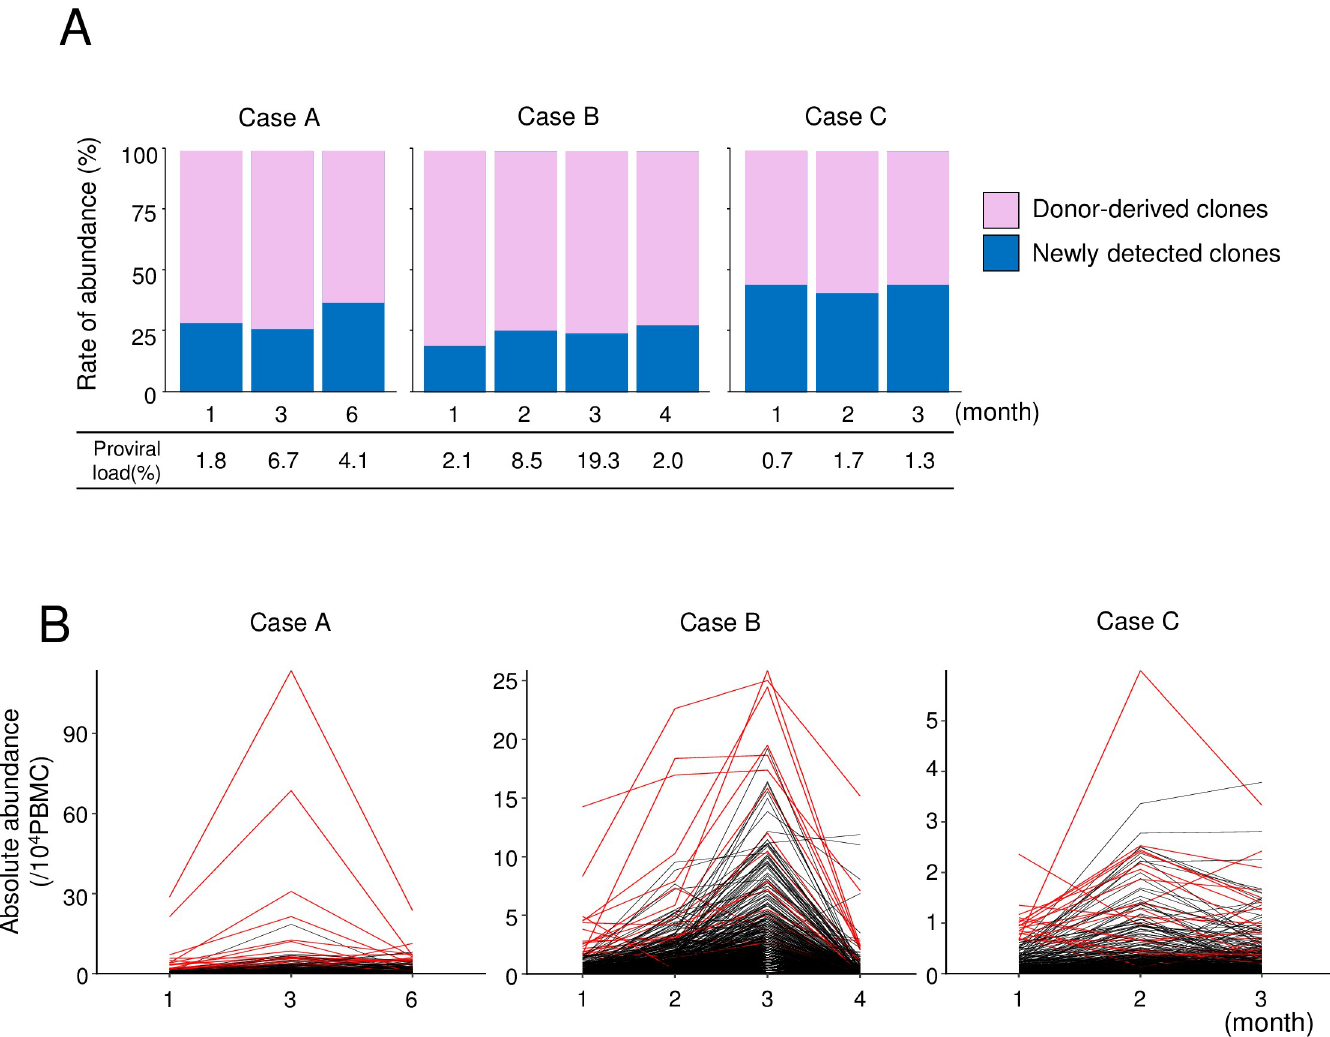
Fig 2. HTLV-1-infected clones in ATL patients who received hematopoietic stem cell transplantation from seropositive donors. (A) The frequencies of HTLV- 1-infected clones that were detected in the donor sample (pink) and clones newly detected in the recipients (blue) are shown for each observation point. (B) Dynamic changes in abundance of infected clones in recipients. The top 20 abundant clones at first observation point are shown in